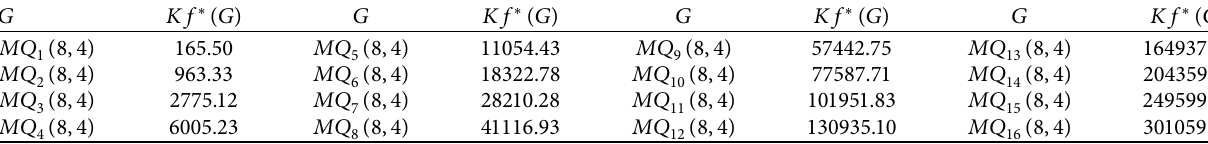
( 8 , 4 ) , MQ ( 8 , 4 ) , . .. , MQ 1 2